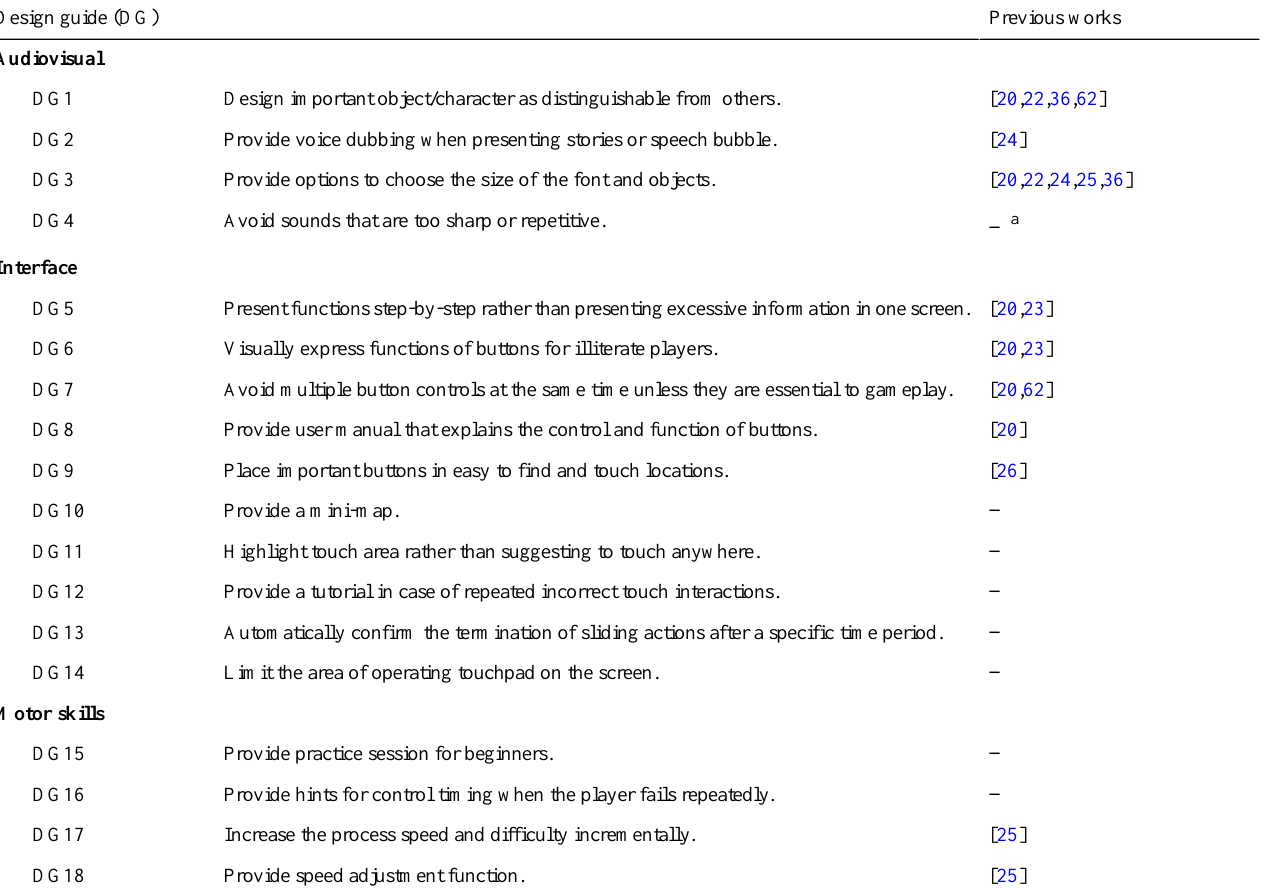
Table 5. Mobile game design guides on cognitive and physical